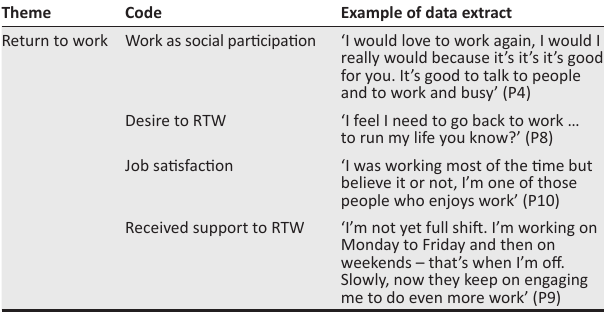
TABLE 2: Example of coding tree used during data